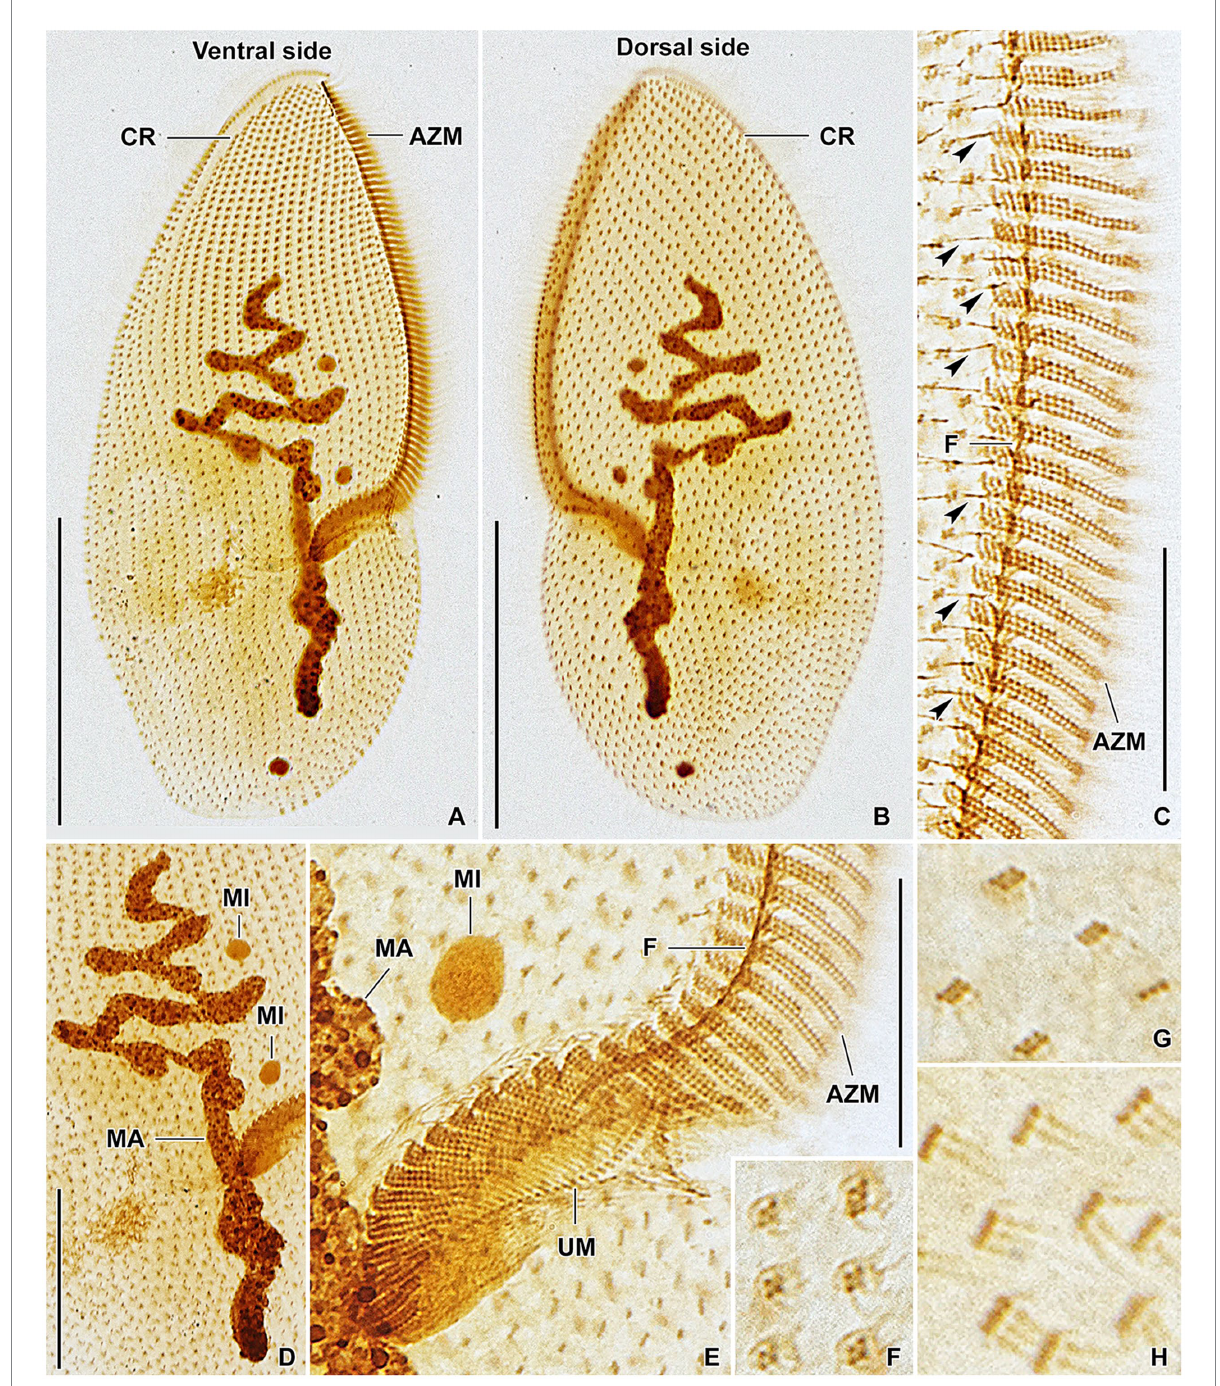
FIGURE 9 Plagiotoma aporrectodeae sp. n., type population after protargol impregnation. (A, B) Cirral pattern of ventral and dorsal sides. Somatic ciliature is “holotrichous”-like, as cirri are indistinct and unspecialized. There are 18–25 ventral and 20–26 dorsal longitudinal cirral rows. (C) Detail showing the fine structure of the adoral zone of membranelles. Individual adoral membranelles are composed of three horizontal rows basal bodies. The anterior row is distinctly shorter than the two other rows. Arrowheads denote fibres connecting cirri with the submembranellar fibre bundle. (D) The nuclear apparatus consists of a branched macronuclear strand and two globular micronuclei. (E) Detail showing the fine structure of the proximal region of the adoral zone of membranelles. Adoral zone occupies about 51–67% of body length and consists of 65–77 membranelles, forming a Gonostomum -like pattern. (F–H) Fine structure of cirri in the anterior body region (G) , mid-body (F) , and posterior body region (H) . AZM, adoral zone of membranelles; CR, cirral rows; F, submembranellar fibre bundle; MA, macronucleus; MI, micronuclei; UM, undulating membranes. Scale bars: 20 μ m (C, E) , 50 μ m (D) , and 100 μ m (A, B)